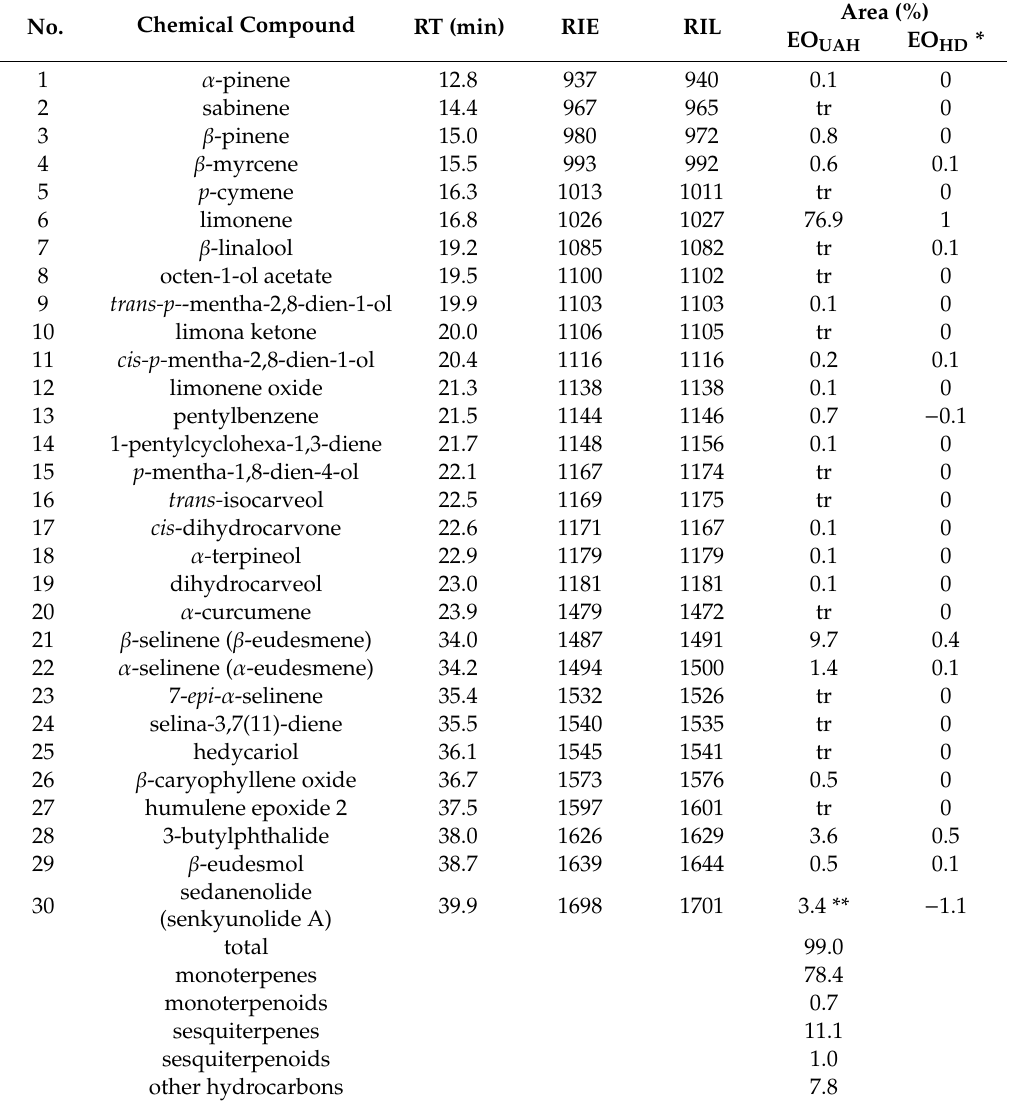
Table 3. Composition of essential oil from ultrasounds pre-treated celery seeds